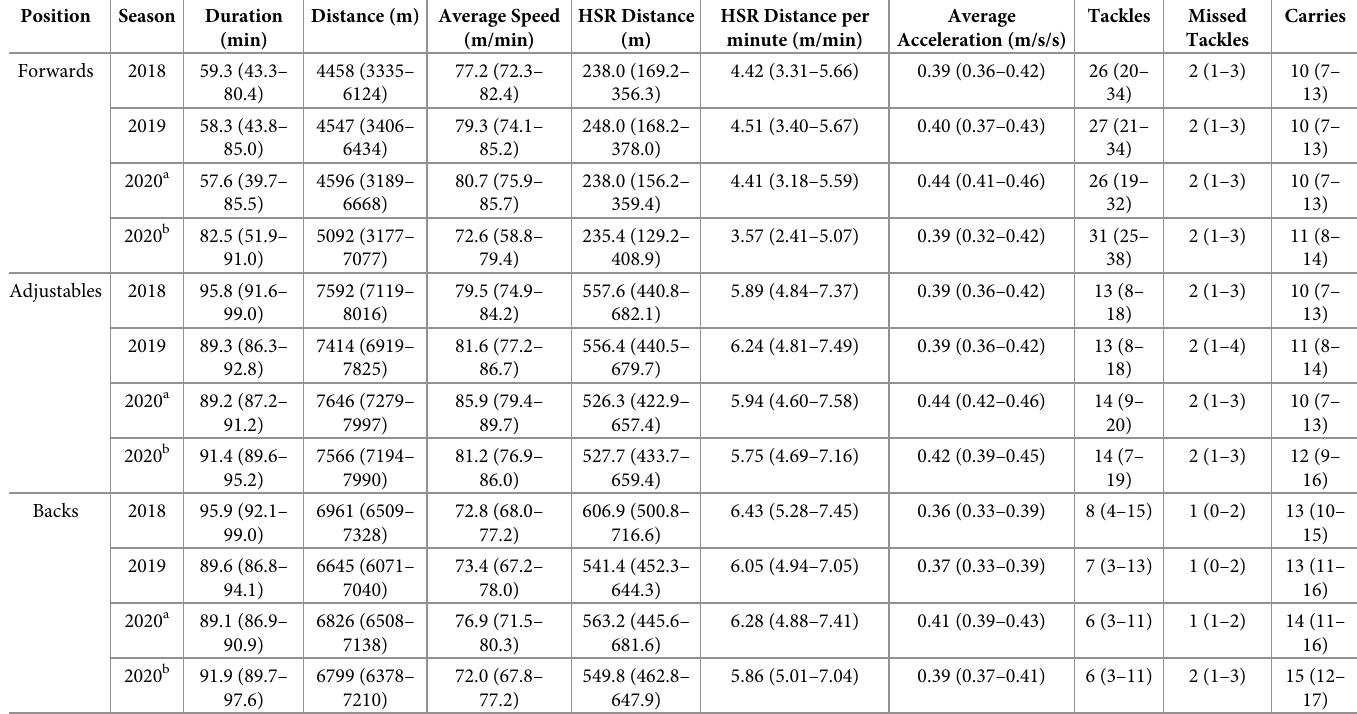
Table 1. Whole-match locomotor characteristics and match events stratified per positional category between seasons (Median [interquartile